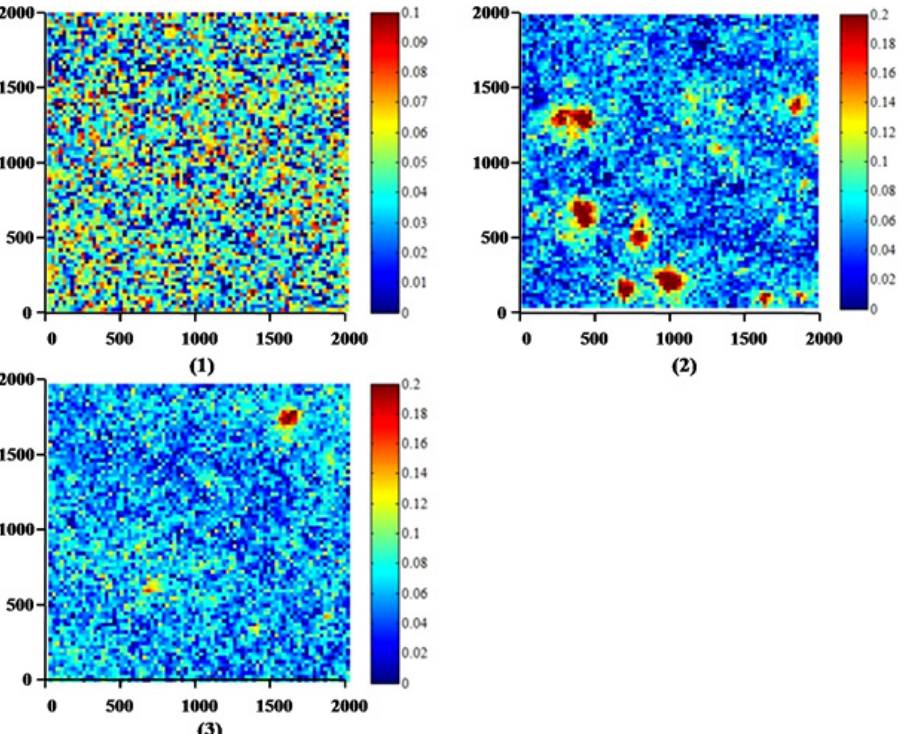
Fig. 3. Concentration value of reconstruction images of three samples in prediction set (1) Sample 1, (2) Sample 2, (3) Sample